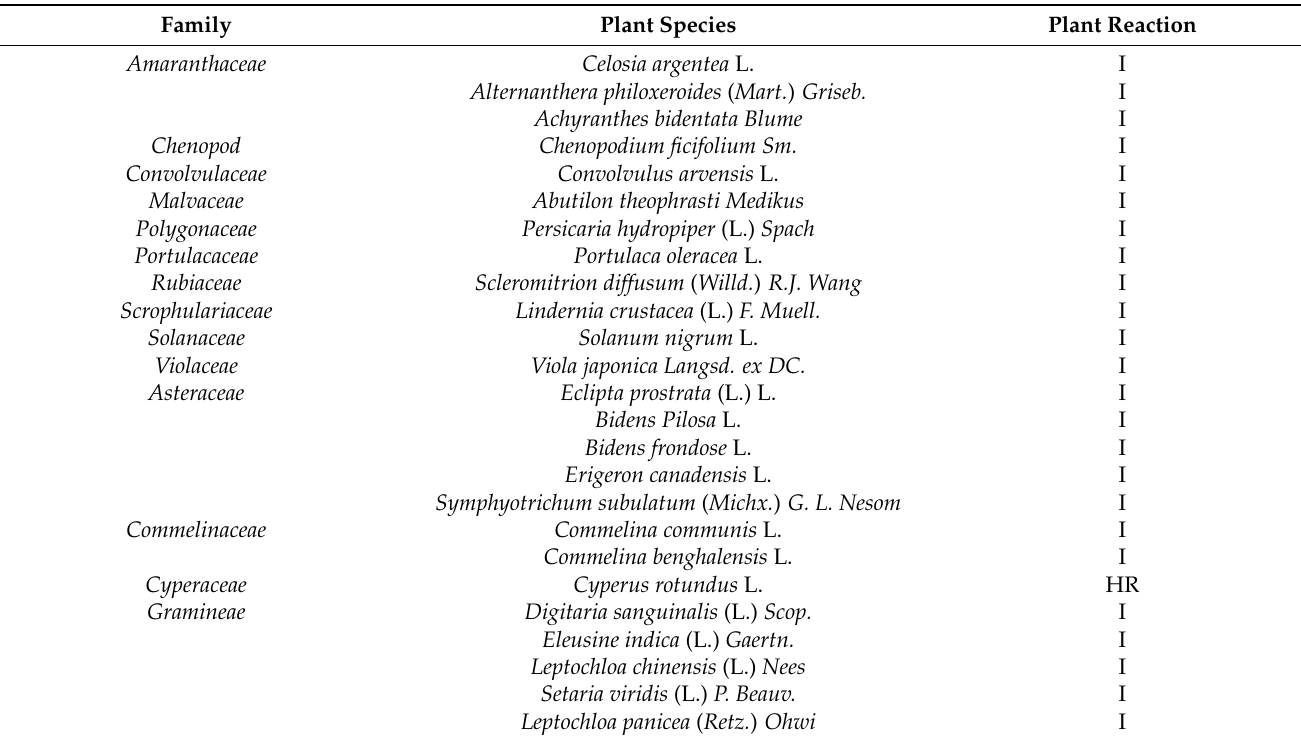
Table 2. Host susceptibility of Colletotrichum echinochloae in major weedy plants in Hubei Province.